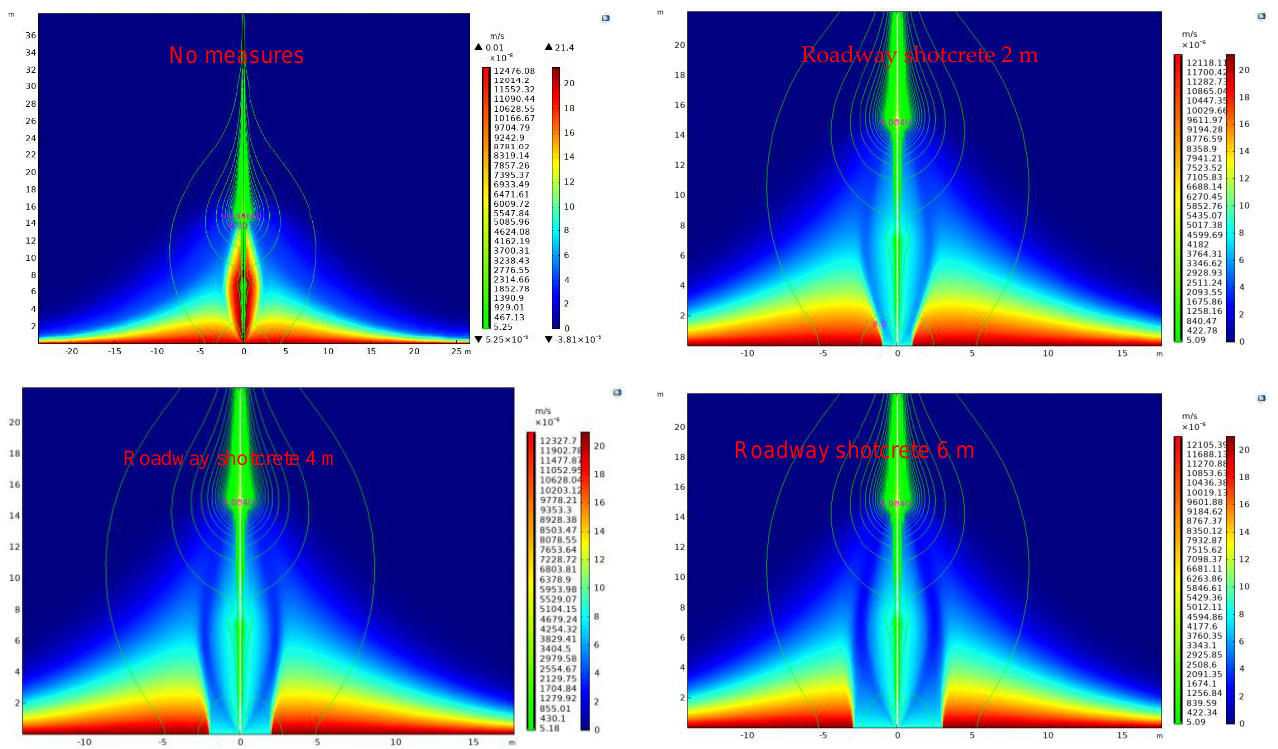
Figure 4. The cloud map of oxygen concentration for different roadway grouting lengths was ob- tained.